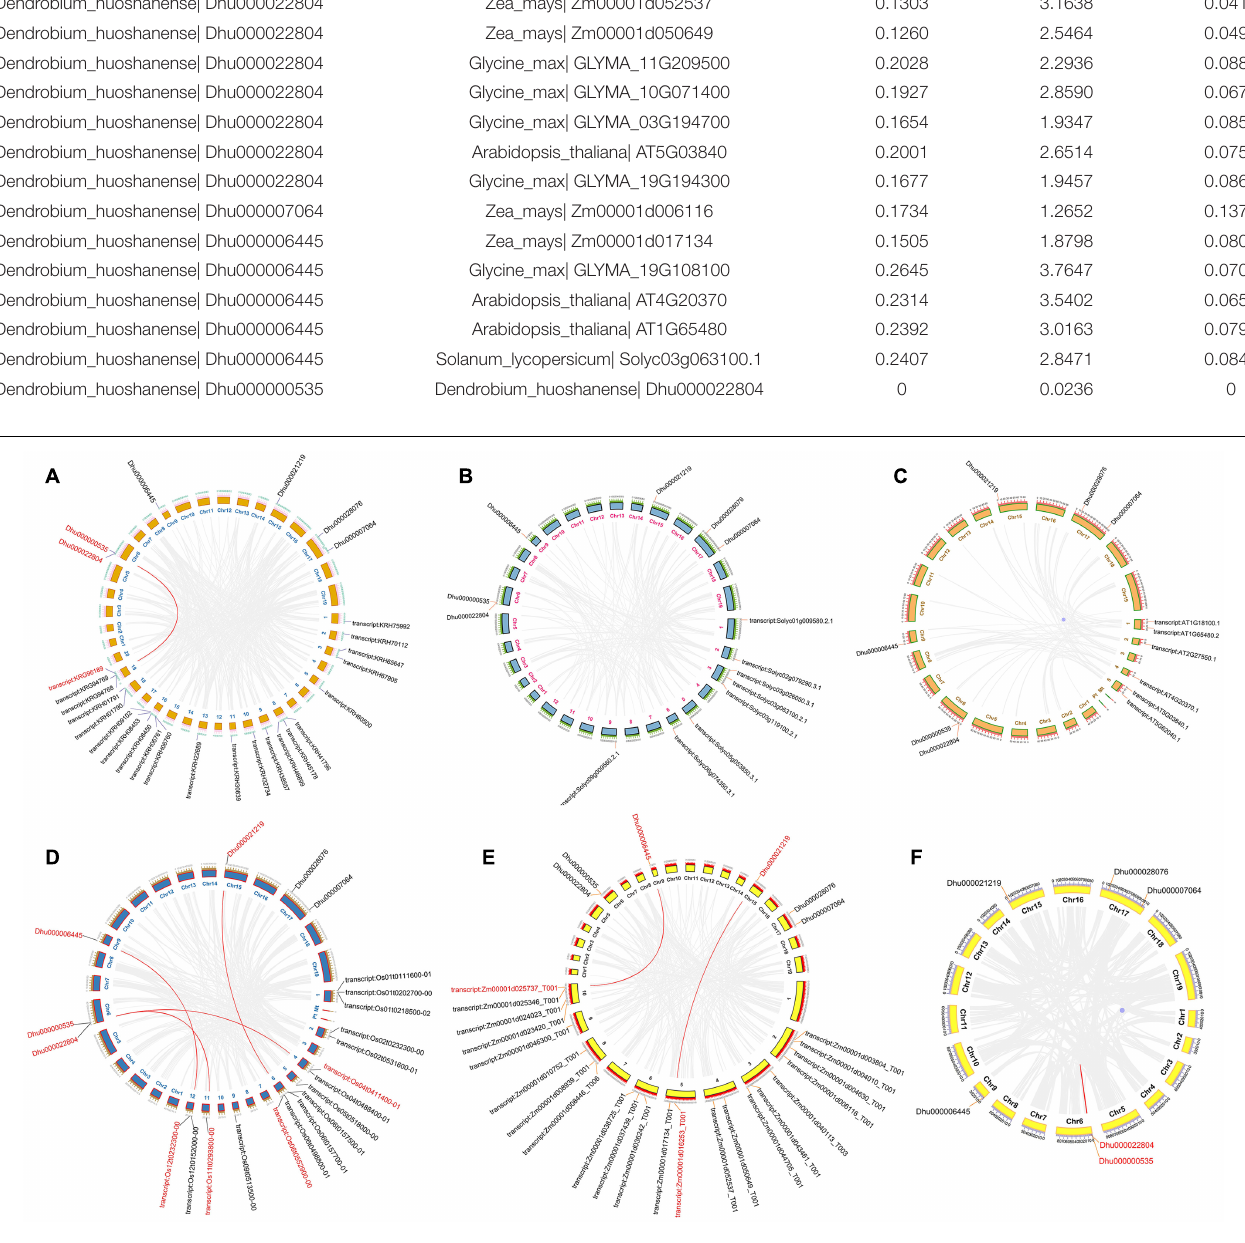
FIGURE 5 | The collinearity and mcirosynteny of D. huoshanense and other species. (A) D. huoshanense and G. max. (B) D. huoshanense and A. thaliana. (C) D. huoshanense and Z.mays. (D) D. huoshanense and S. lycopersicum. (E) D. huoshanense and O. sativa. (F) D. huoshanense and D. huoshanense.